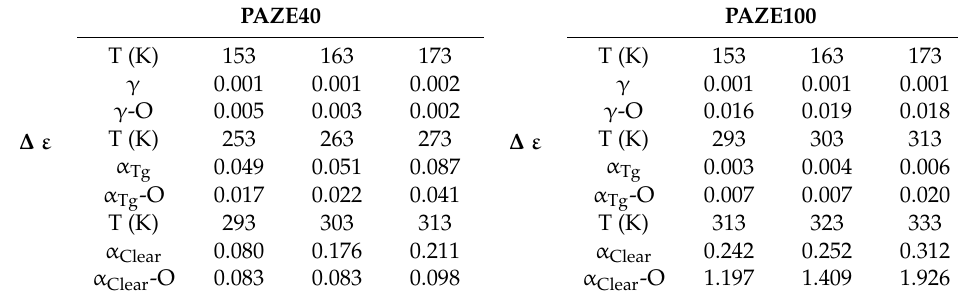
Table 1. Detail of ∆ ε obtained from the fitting of the Havriliak–Negami equation. Table 1. Detail of Δε obtained from the fitting of the Havriliak–Negami equation.